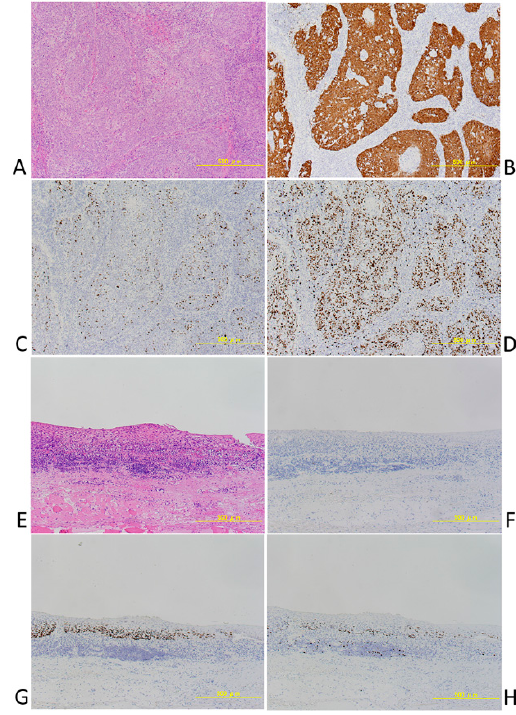
Figure 2. ( A – D ) A case of P16 positive squamous cell carcinoma of Oropharynx. ( A ) HE, ( B ) P16 , ( C